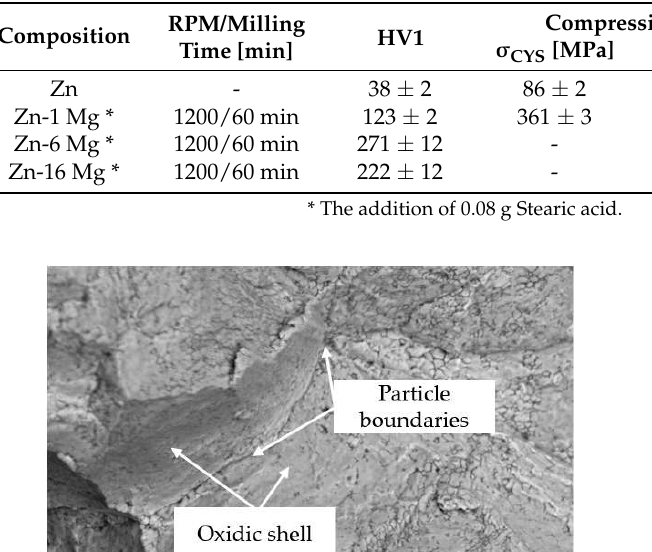
Table 4. Mechanical properties of materials compacted by the SPS.